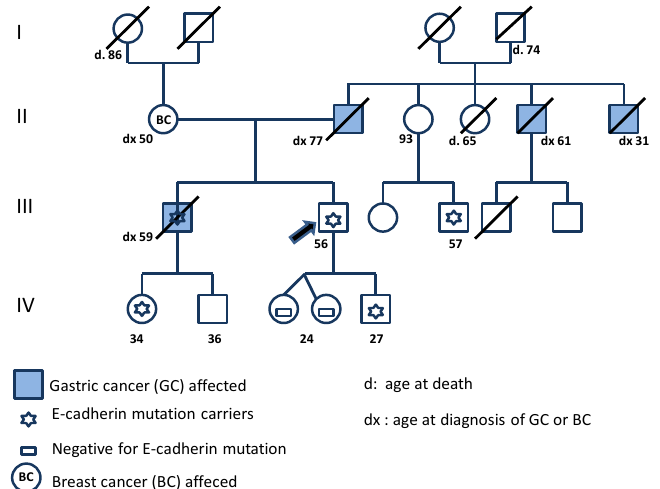
Figure 1. Family genetic pedigree with p.His 121Thrfs*94 variant in the CDH1 gene. Arrow points to the proband. The shaded square and circle represent the male and female among the family members, respectively. Numbers indicate the age or the age at death in years; dx indicates the age at diagnosis, in years. Gastric cancer (GC); Breast cancer (BC).